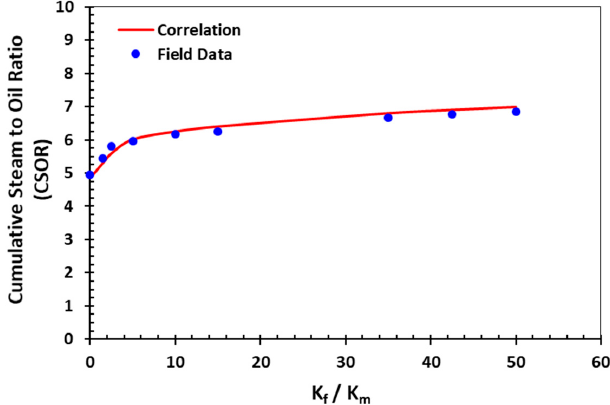
Figure 2. CSOR vs. steam injection rate for the database analyzed. Figure 3. CSOR vs. steam injection rate for the database analyzed. Energies 2018 , 11 , x FOR PEER REVIEW